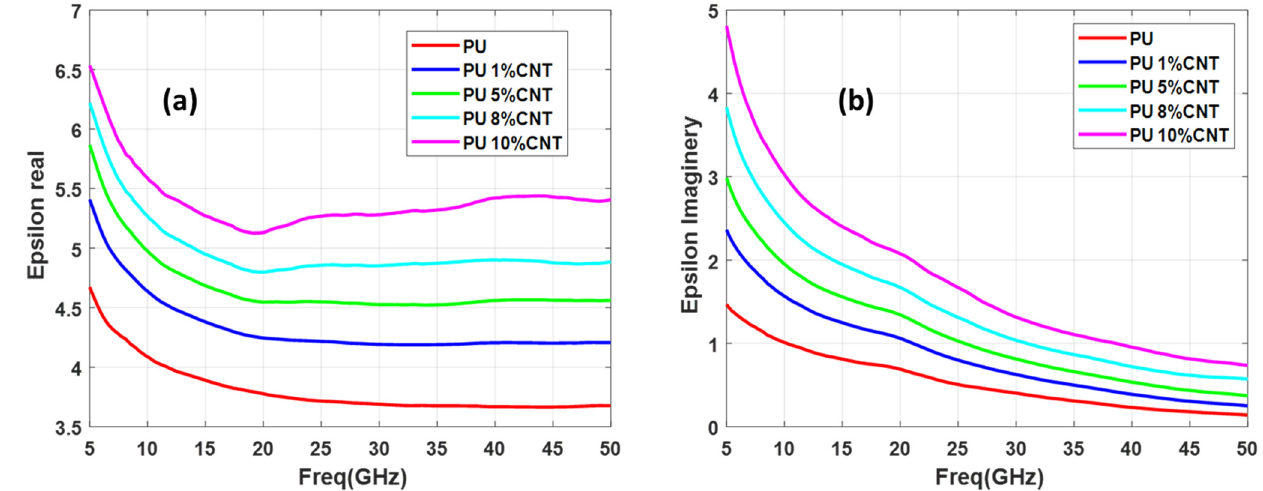
Figure 6. PU with different concentrations of CNT ( a ) epsilon real ( b ) epsilon imaginary.